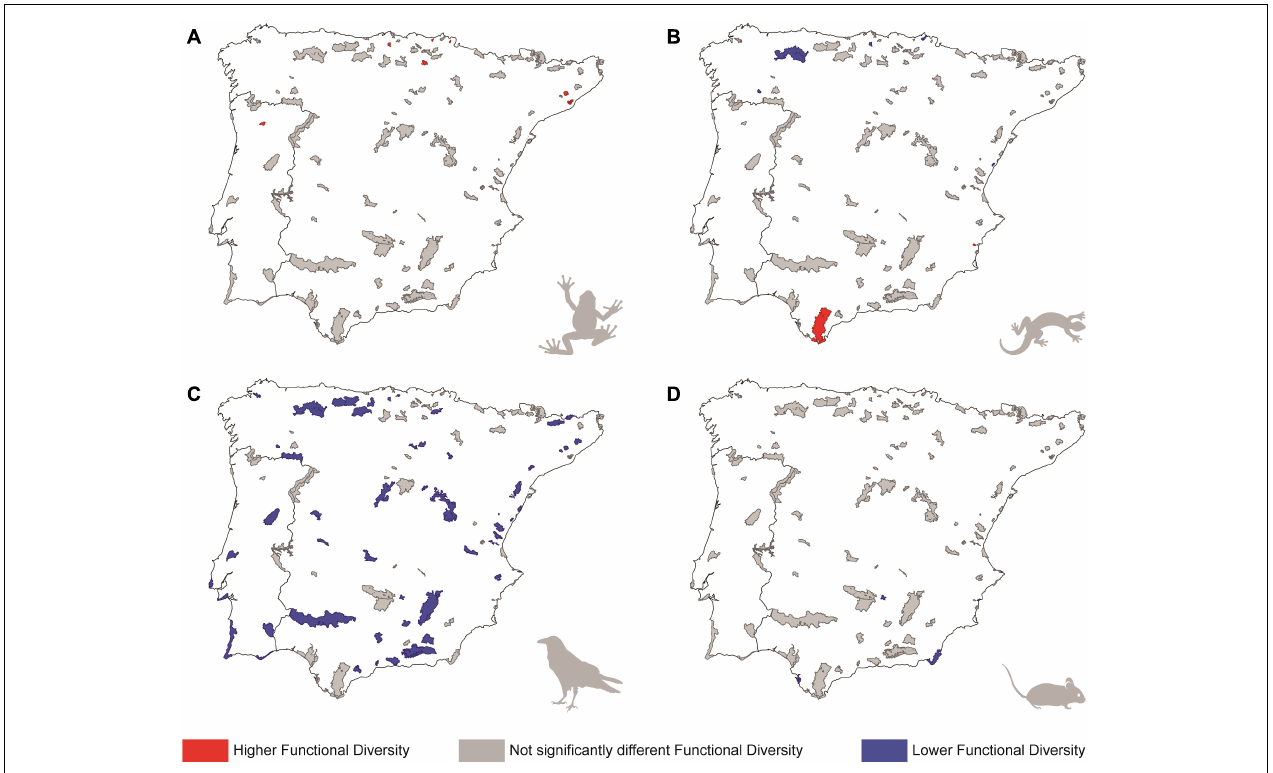
FIGURE 1 | Representation of the protected areas according to the level of significance of the standardized effect sizes of functional diversity for different tetrapod groups: (A) amphibians, (B) reptiles, (C) birds, and (D) mammals. Colours indicate whether each protected area holds significantly higher (red) or lower (blue) functional diversity than it is expected from the region where it stands (an area designed placing its limits 50 km beyond the boundaries of the PA, including also the PA); parks in grey correspond to those where functional diversity does not differ from a random draw of species from the region where they stands (see main text for more